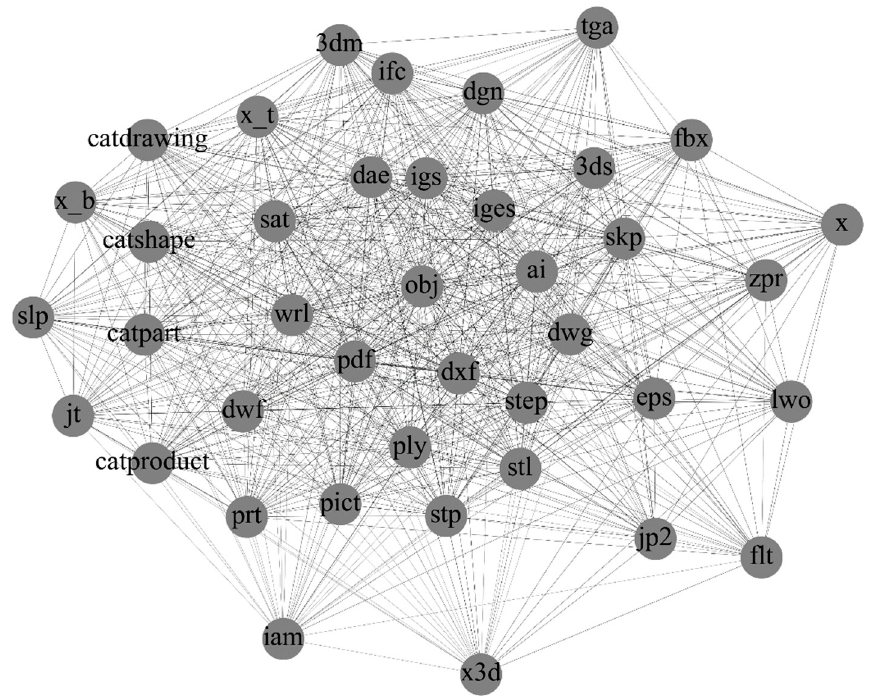
Figure 2. The subgraph consists of 40 nodes with the largest degree of data formats in CAD.